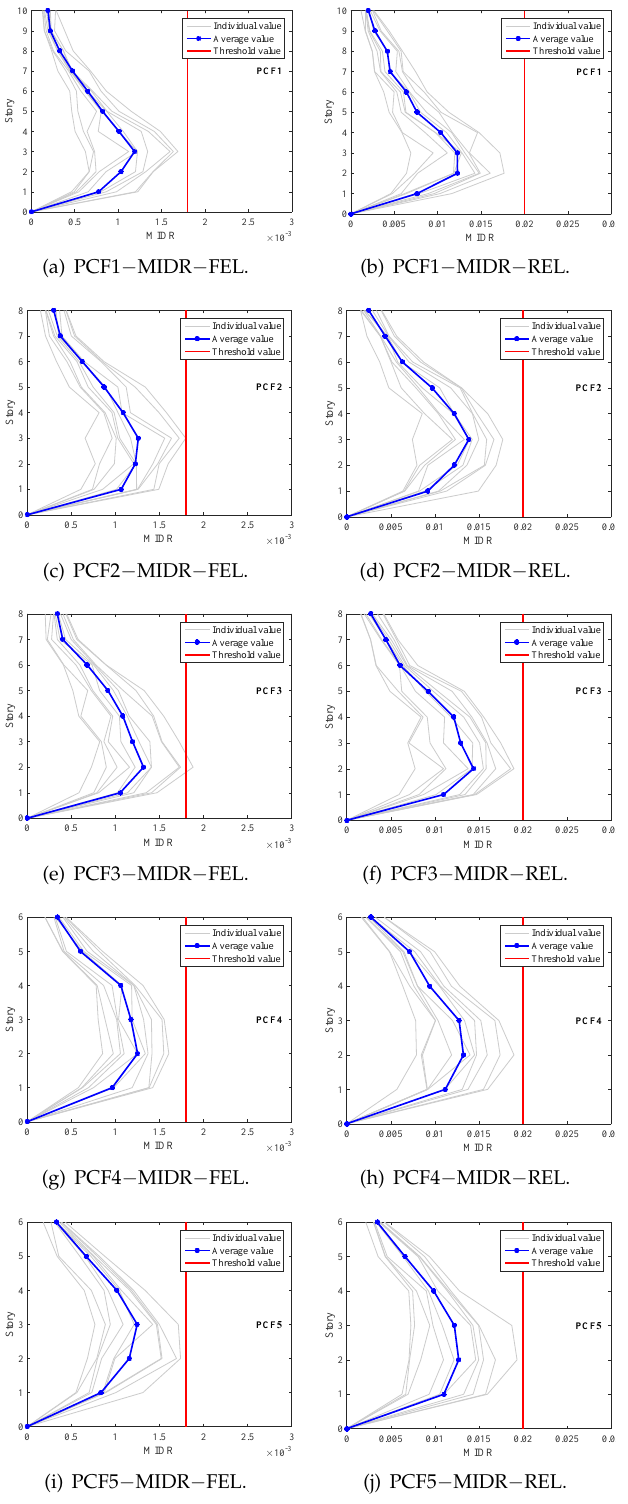
Figure 9. MIDR development along the structural height under the stochastic nonstationary earth- quakes for both the FEL and the